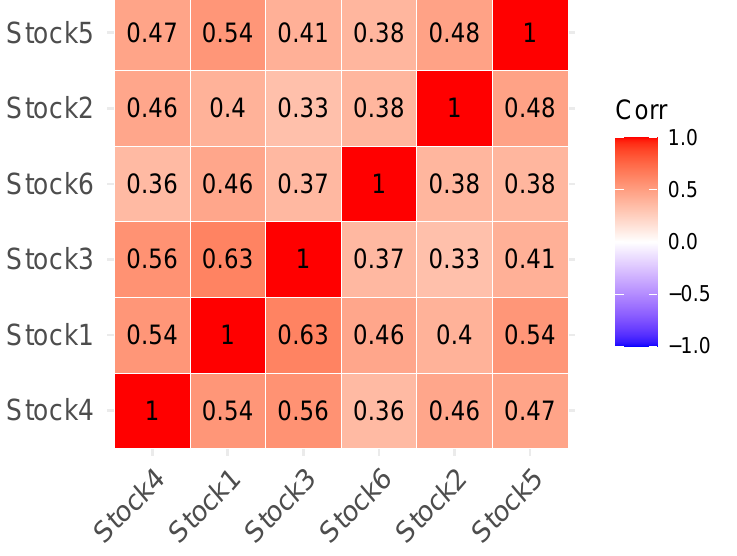
Figure 5. Correlation among